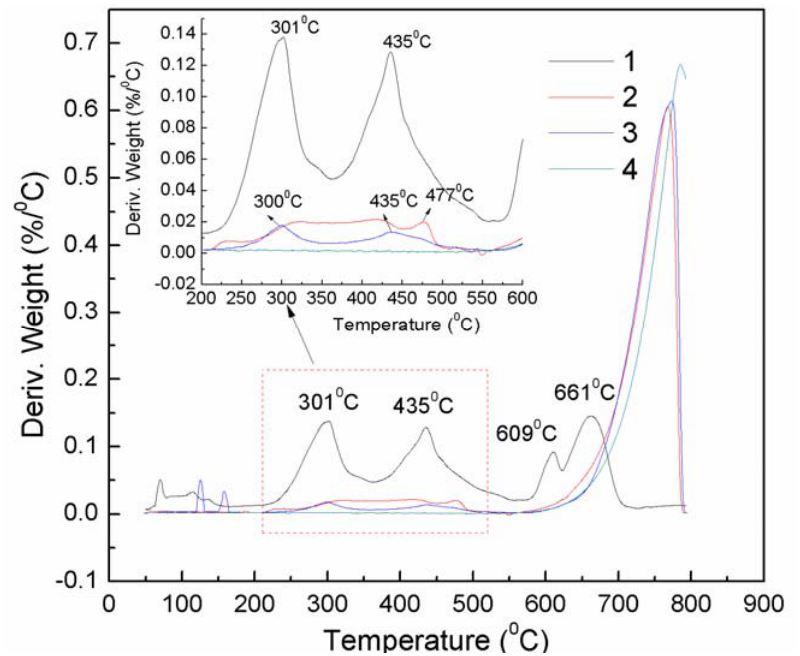
Figure 4. DTG curves of powders APRB ( 1 ), the CaCO /APRB mixture ( 3 ) and CaCO CaCO 3